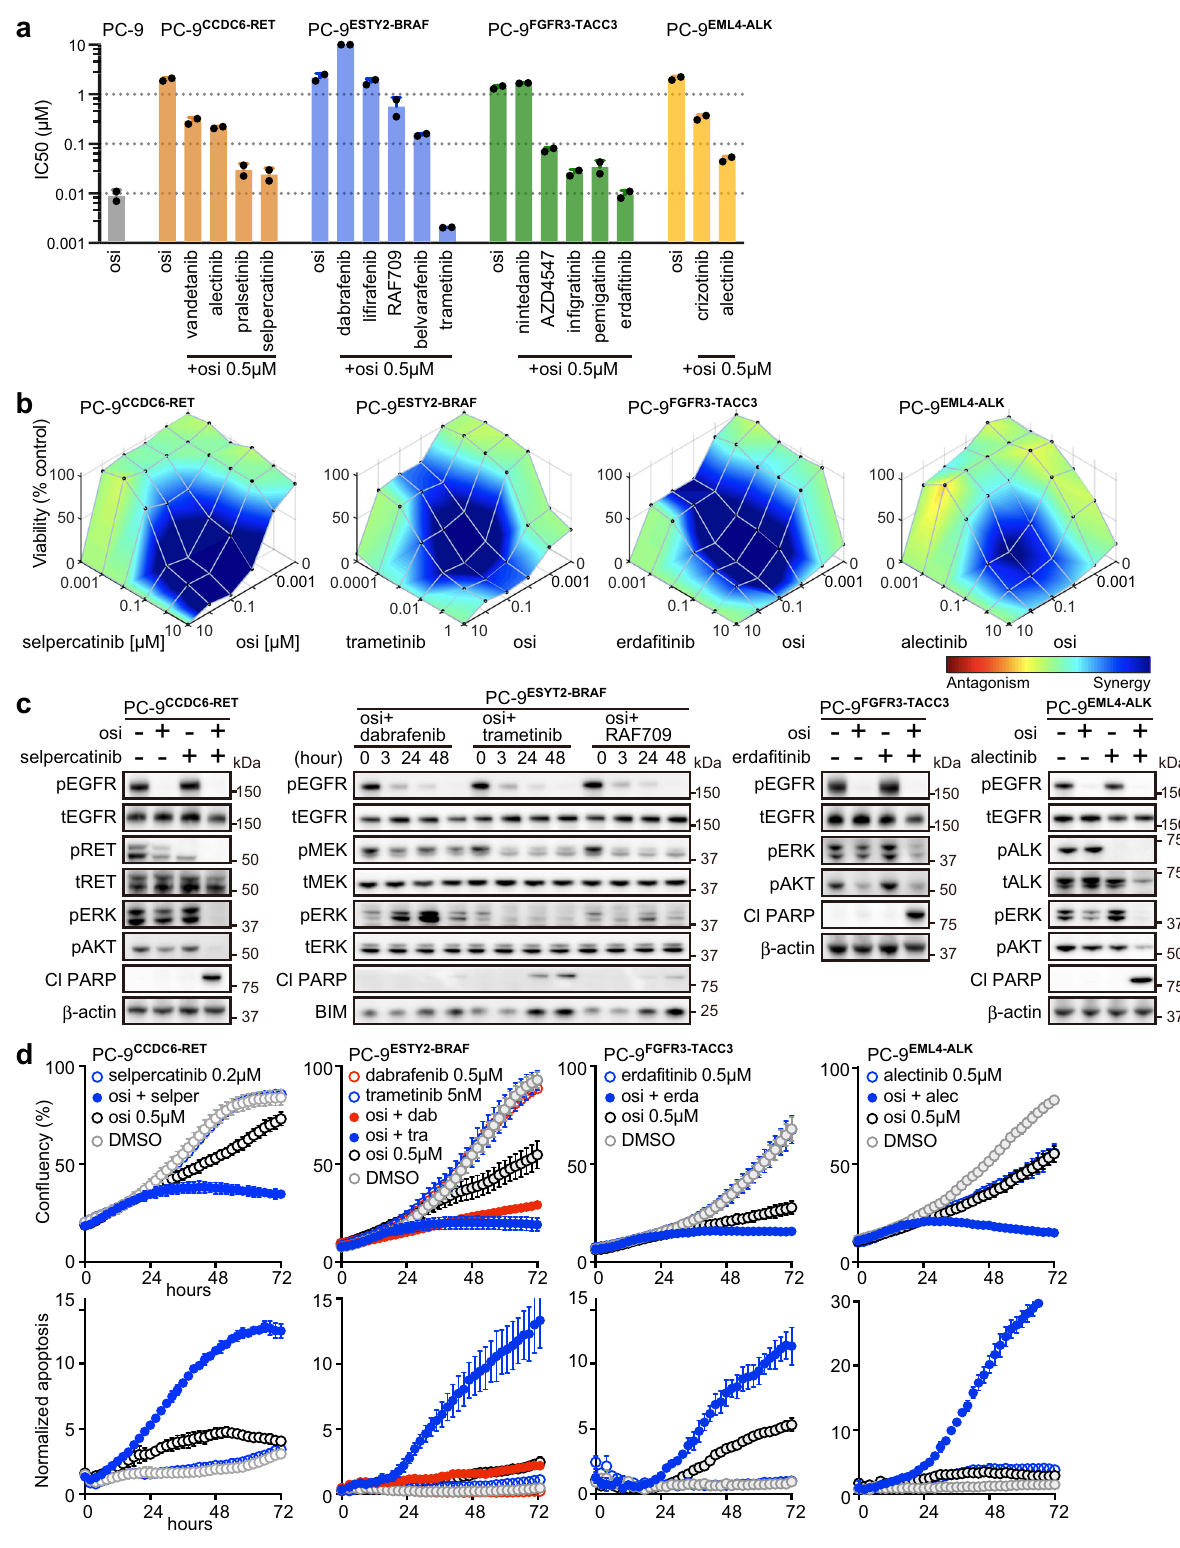
Fig. 6 | Effective combination therapies in CRISPR-modi fi ed fusion models. a The half maximal inhibitory concentrations (IC50s) of osimertinib and indicated drugs in parental PC-9 and in single clones from CRISPR-modi fi ed PC-9 models, after72hoftreatment.Foreachfusionmodel,we usedtwosingleclones.Eachdot indicates the mean of biological triplicate data. b Synergistic inhibitory effects of osimertinib and individual drugs in CRISPR-modi fi ed PC-9 models as shown by